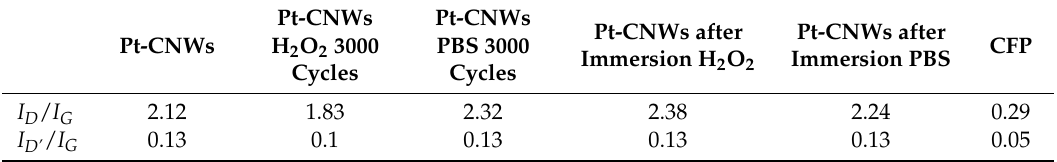
Figure 5. Raman spectra of as-formed Pt-CNWs and Pt-CNWs after 3000-cycle test in PBS solution with and without 240 µ M of H 2 O 2 , with those of Pt-CNWs just after immersion in PBS with and without H 2 O 2 for 42 hours, and that of CFP without CNWs. Table 1. Ratio of I D / I G and I D’ / I G in each condition of (i)–(vi).